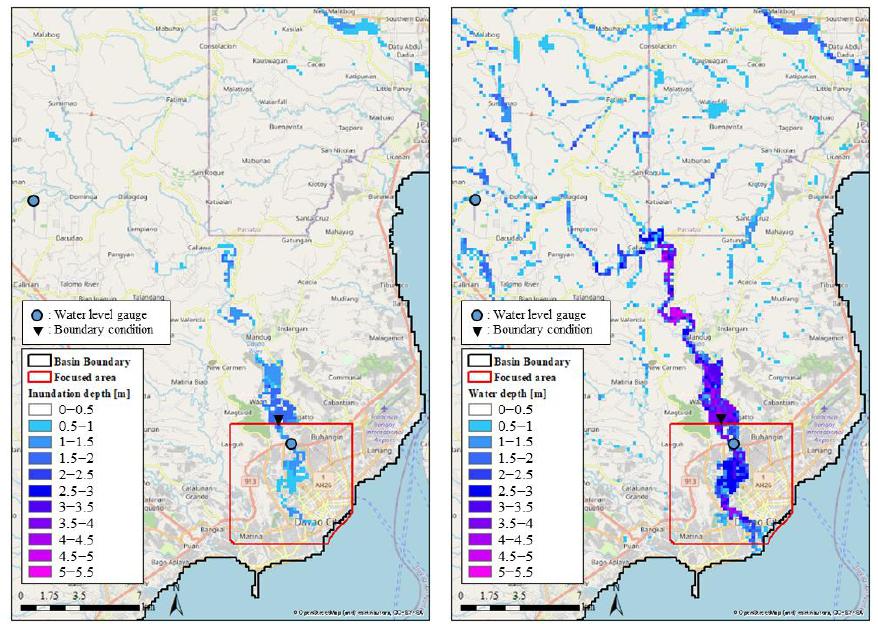
Figure 8. Basin-scale inundation maps of the worst extreme events in the past ( left ) and future ( right ) climate. The inundation extent in the future is more than 4 times that of the past.